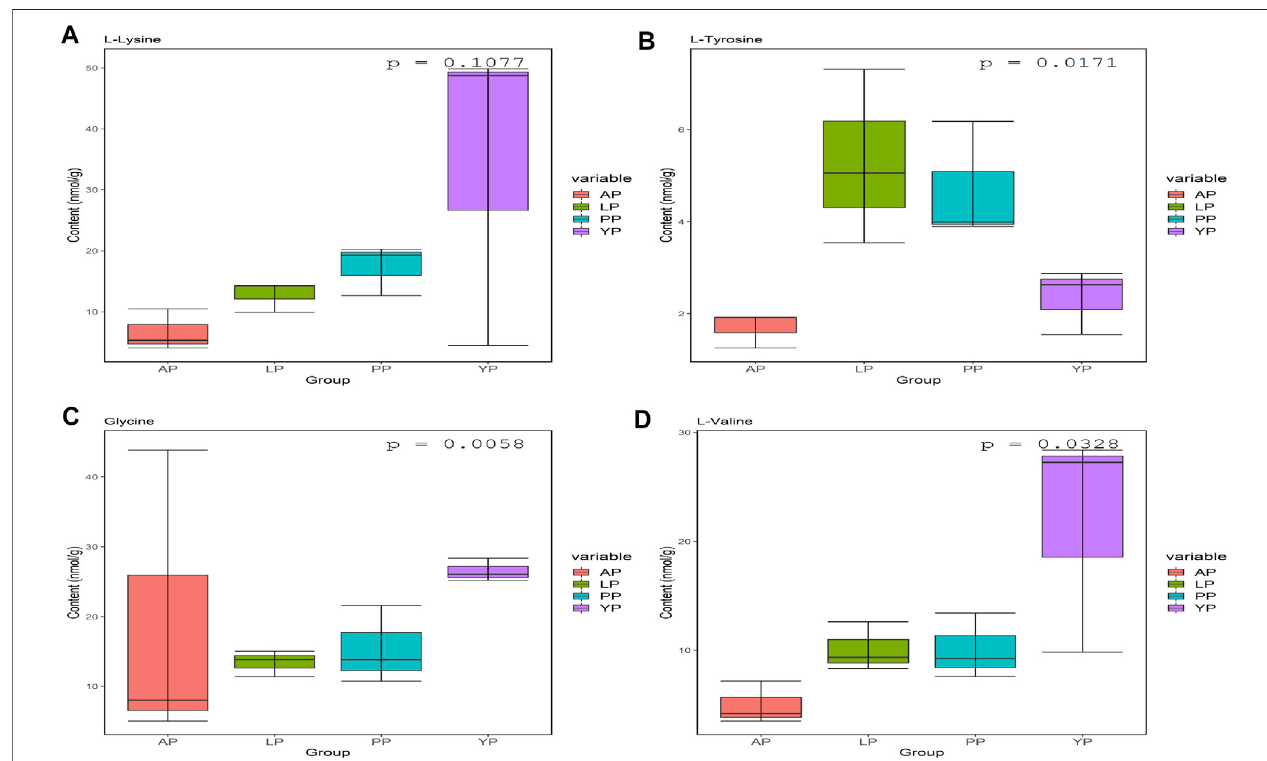
FIGURE 4 | Lys (A) , Tyr (B) , Gly (C) and VAL (D) contents (nmol/g) in fresh yak pericardium (YP); fresh Australian bovine pericardium (AP); fresh local bovine pericardium (LP) and fresh porcine pericardium